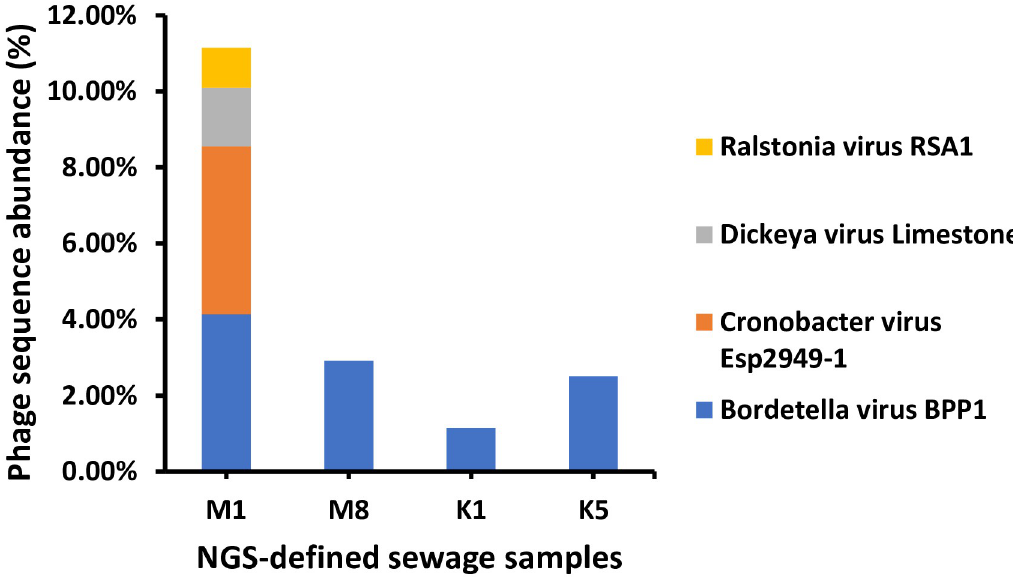
Fig 6. Relative abundance of phage sequence in NGS-defined sewage samples. M1: first sample from MN-WWTP, M8: eighth sample obtained from MN-WWTP, K1: first sample obtained from KSU-WWTP and K5: fifth sample obtained from